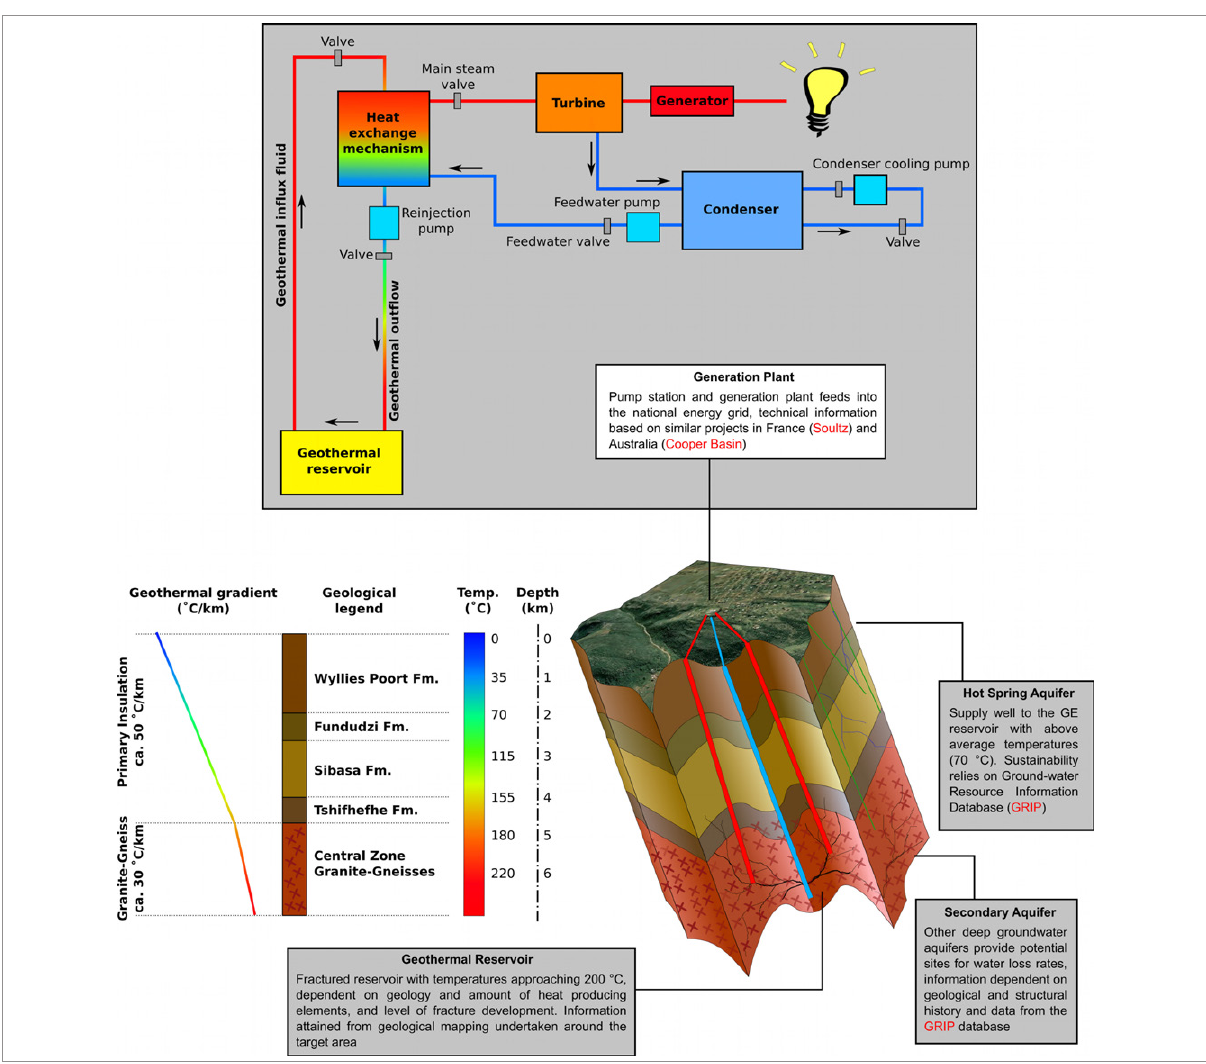
Figure 1: Schematic illustration of the hypothetical enhanced geothermal system plant in the Limpopo Province. The blue line indicates the influx well and the red line indicates the outflow/production wells. Also shown is the depth, geological profile, geothermal gradient and detailed binary production